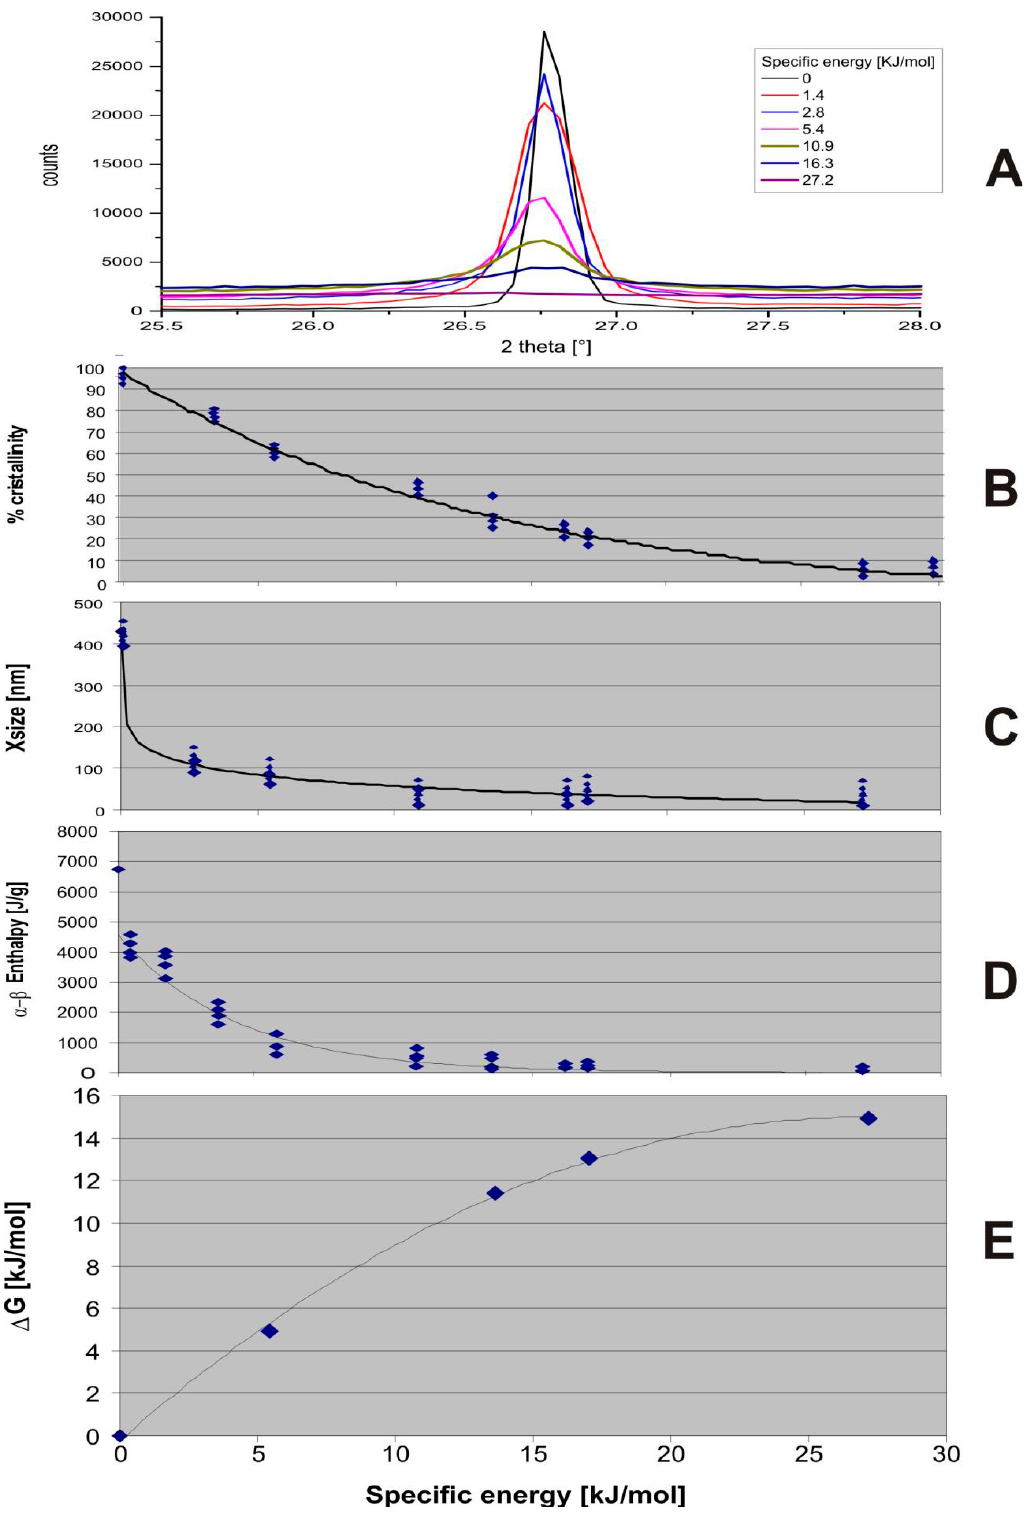
Figure 1. Correlations between the microstructural and chemical parameters of quartz vs. specific energy.( A ) The X-ray diffraction peak (101) of α -quartz; ( B ) crystallinity vs. specific energy; ( C ) crystallite sizevs. specific energy; ( D ) DSC analysis of the energy of the transition α−β of quartz vs. specific energy; ( E ) correlation between Gibbs free energy vs. specific energy.